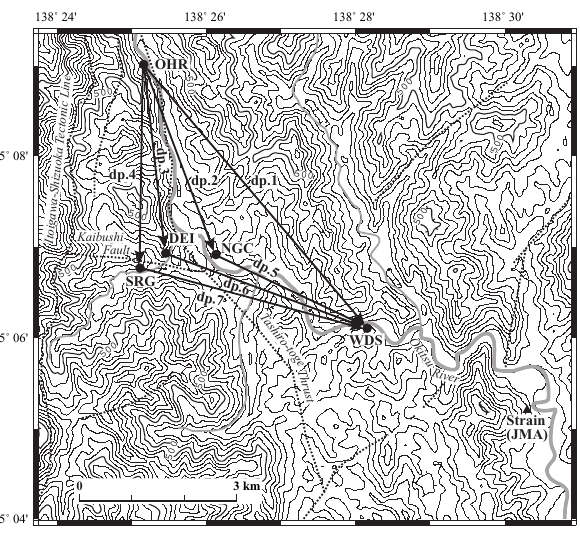
Fig. 2. Configuration of dipoles at Shimizu (SMZ) GPD station and location of the JMA strainmeter. Dotted lines indicate faults (Sugiyama and Shimokawa,